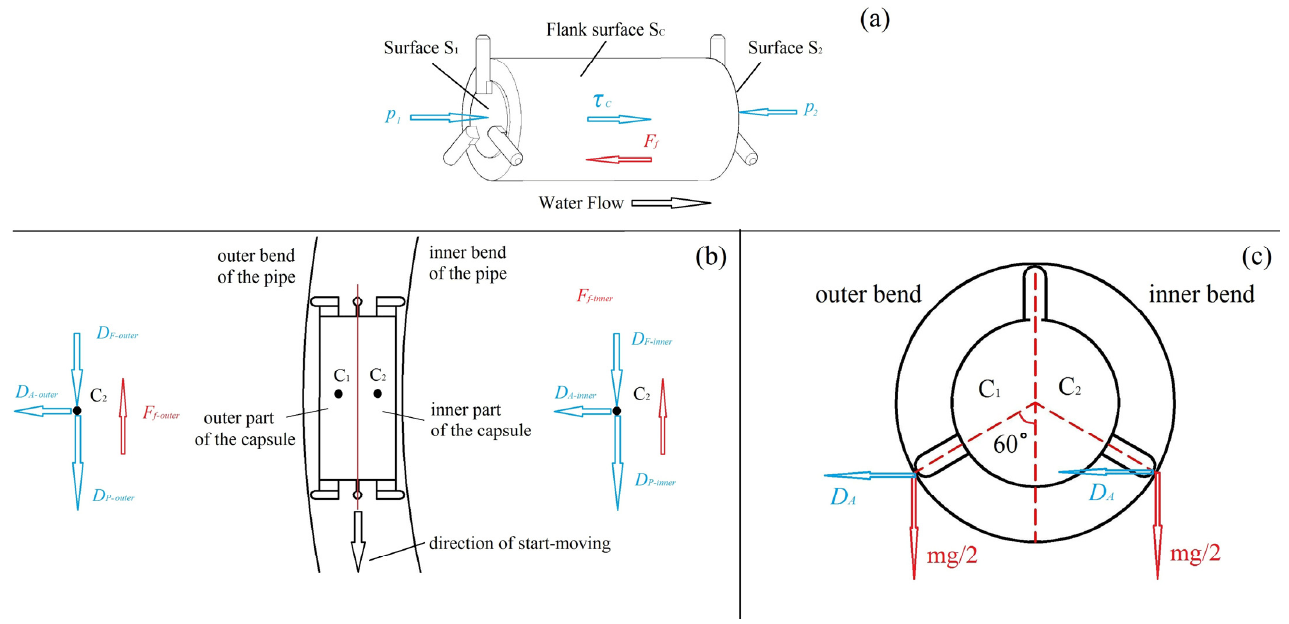
Figure 11. The mechanics schematic of wheeled capsule: ( a ) schematic of the wheeled capsule in straight pipe; ( b ) schematic of the wheeled capsule in bend pipe; ( c ) asymmetry force condition of wheeled capsule in bend pipe. The red vectors are the equivalent forces of surface stress; the blue vectors are the concentrate forces.